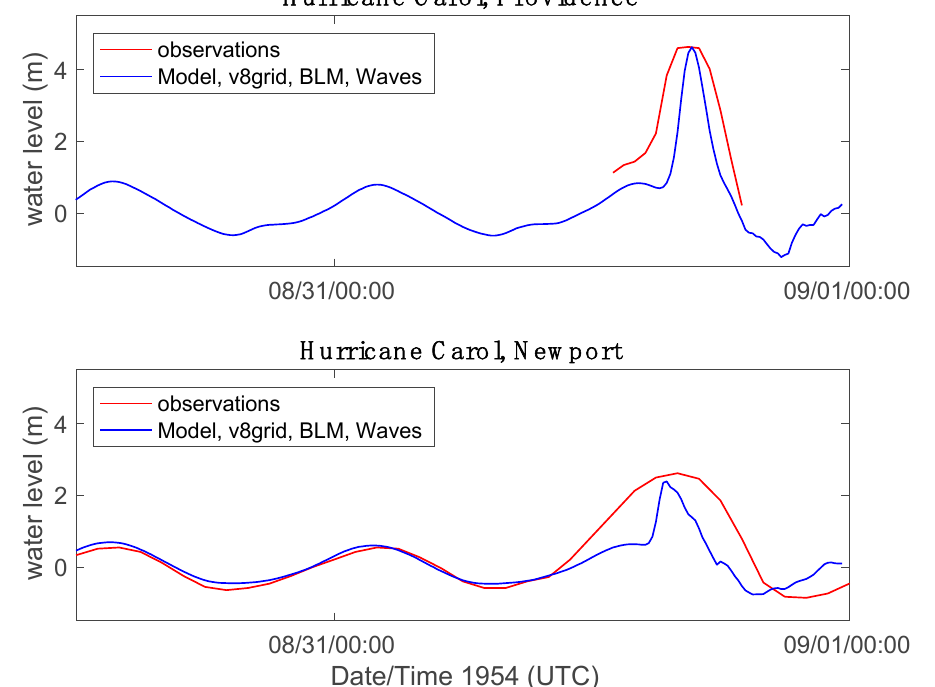
Figure 7. Time series comparison of model and observed water levels during Hurricane Carol at Providence ( top ) and Newport ( bottom ).